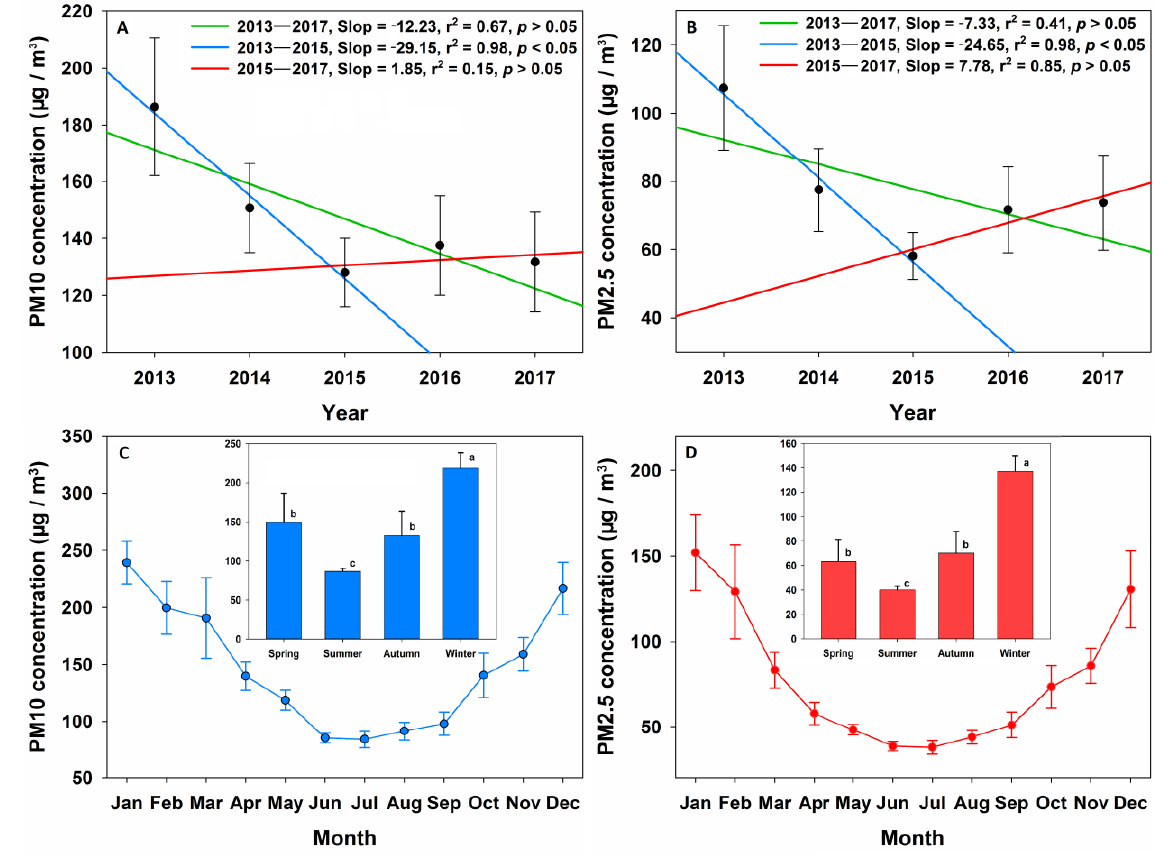
Figure 2. Annual, seasonal, and monthly variations in the concentrations of PM10 and PM2.5. ( A ): interannual variation of PM10; ( B ): interannual variation of PM2.5; ( C ): intraannual variation of PM10; ( D ): intraannual variation of PM2.5.